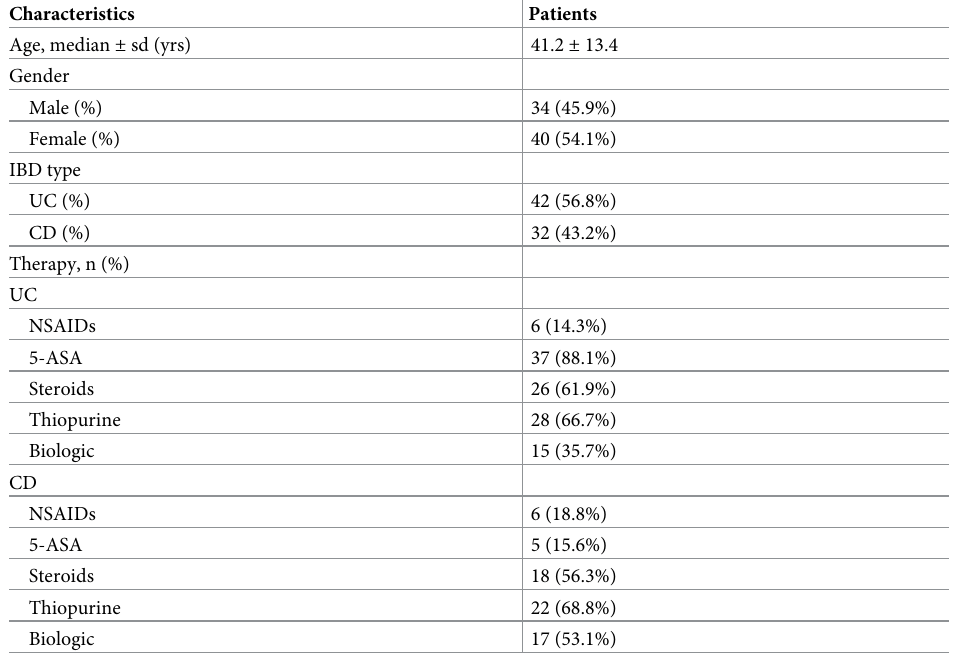
Table 1. Demographics of patients included in the analysis of mucosal healing vs. active